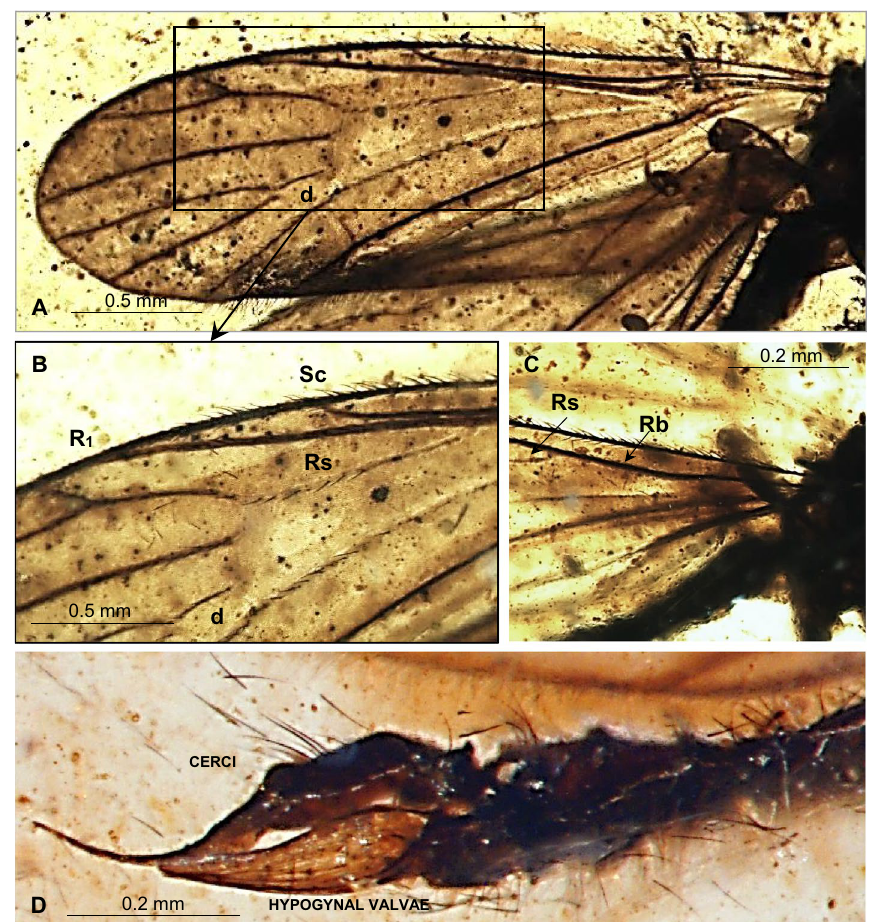
Figure 4. Gonomyia ( Iberiana ) penalveri subgen. et sp. nov. (Limoniidae), inclusions in Spanish amber: ( A ) wing; ( B ) enlarged view of part of wing; ( C ) base of wing; ( D )